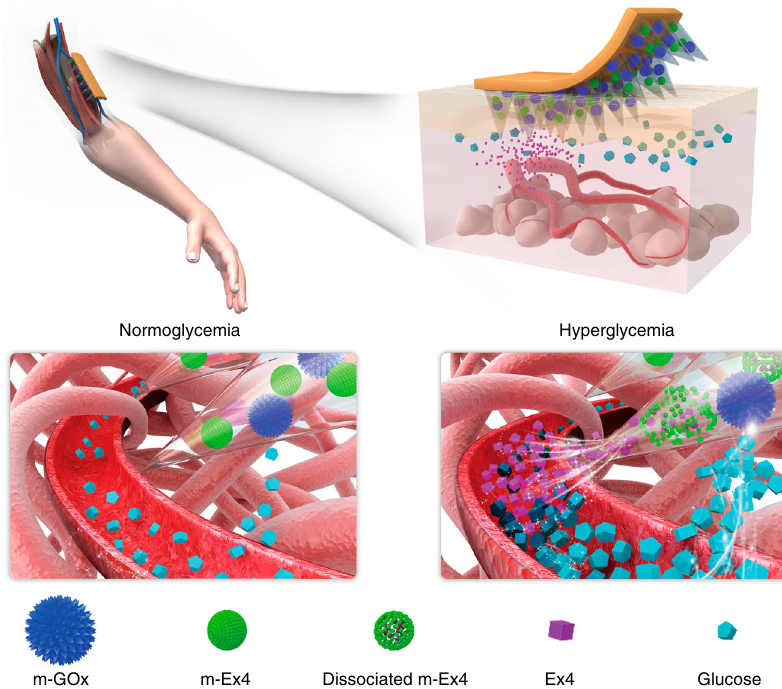
Fig. 1 Schematic of glucose-responsive Ex4 delivery MN-array patches. After protein/peptide mineralization and MN fabrication, the patch can be directly administered onto the skin. In the normoglycemic state, relative lower glucose concentration only induces a mild pH decrease under m-GOx catalysis, which is not suf fi cient to induce m-Ex4 dissociation to release the payloads. In contrast, when blood glucose concentration rises to the hyperglycemic level, the signi fi cant pH decrease triggers rapid m-Ex4 dissociation to release Ex4 for blood glucose regulation, suggesting a pathology-speci fi c drug release. Moreover, m-GOx is stable and robust in the whole process, providing long-term responsiveness to glucose change. In this manner, a smart, long-acting, and on-demand Ex4 release is